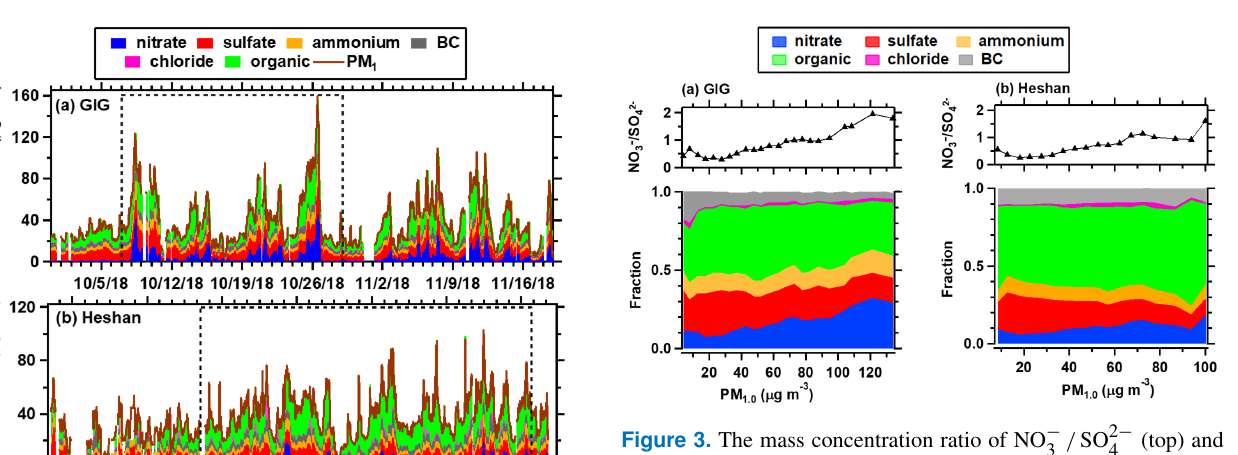
Figure 3. The mass concentration ratio of NO fractions of major chemical components (bottom) in PM 1 at (a) GIG site and (b) Heshan ), sulfate 3